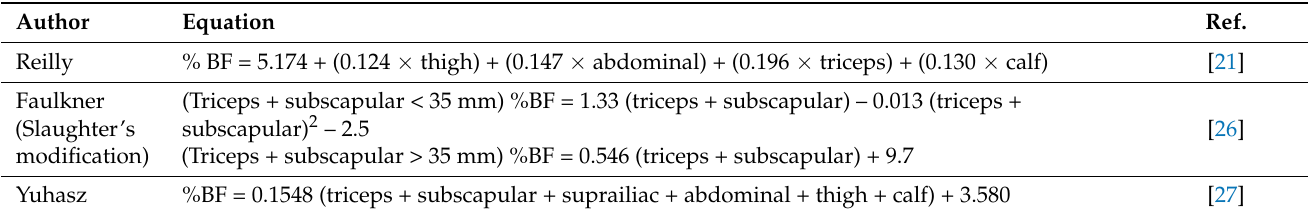
Table 1. Skinfold equation used to estimate body fat percentage (%BF) in